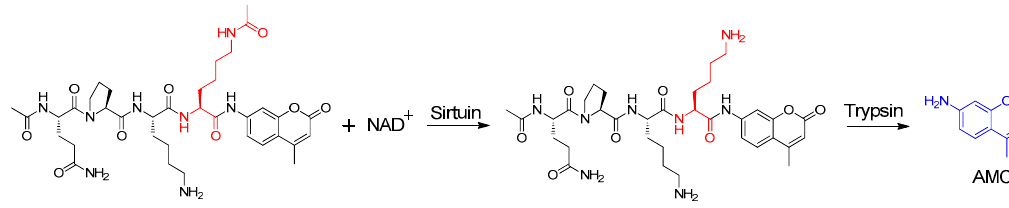
Figure 2. The principle of AMC labelled fluorescence turn-on sirtuin assay. The AMC labelled peptide containing an acetylated lysine, in which the fluorescence is quenched. This peptide was used as the substrates in the assay and can be deacetylated by sirtuin enzyme in the presence of NAD + . The deacetylated peptide is then digested by trypsin to release the free AMC, which has turn-on fluorescence. Thus, the measured fluorescence intensity can be used as a readout for the activity of the sirtuin enzyme.